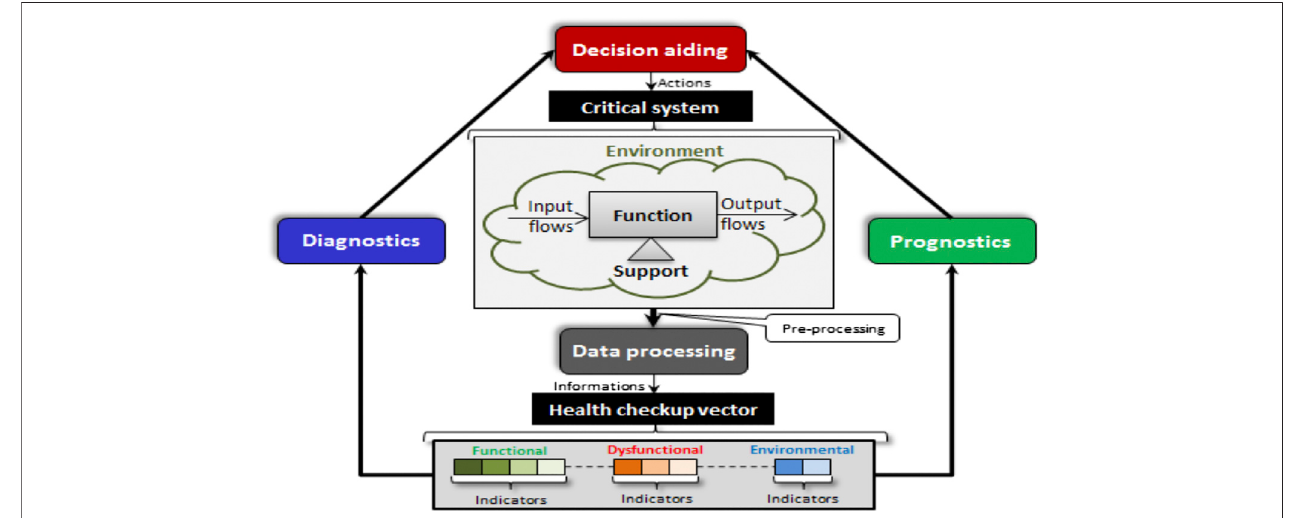
FIGURE 4 | Generic architecture of PHM